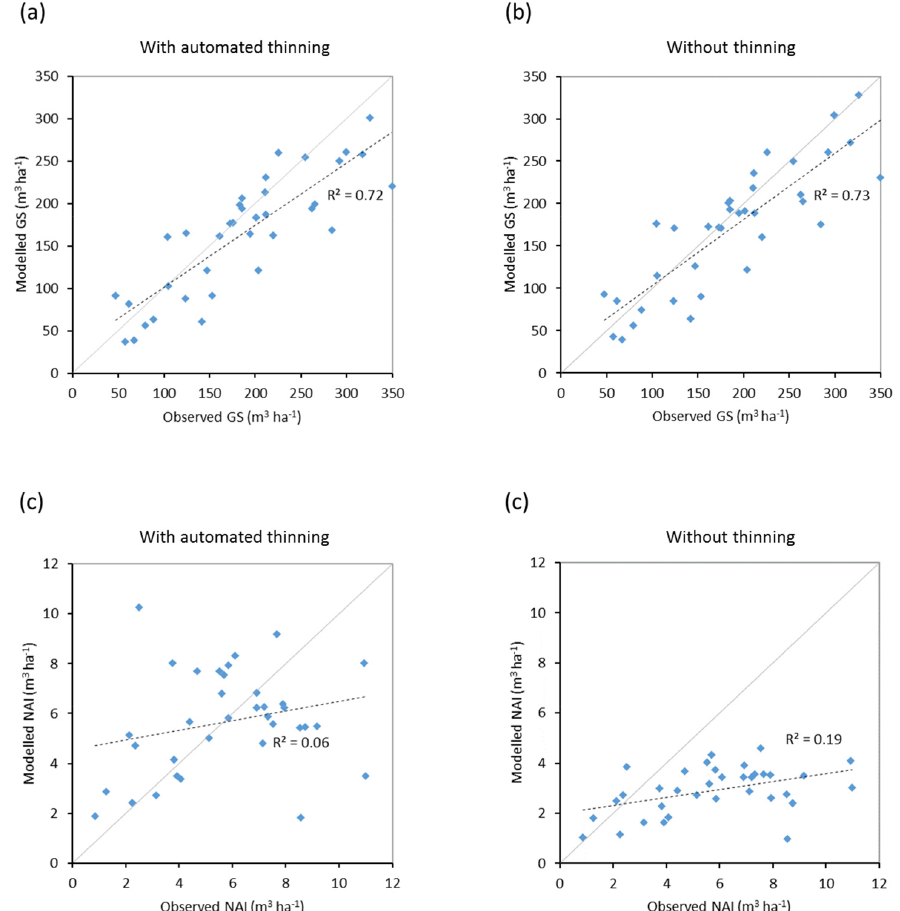
Figure 10. Modelled and observed (Forest Europe, 2015) values for individual European countries. Growing stock (GS) in 2010 (a) simula- tion with automated thinning and (b) simulation without thinning. Net annual increment (NAI) in 2001–2010 (c) simulation with automated thinning and (d) simulation without thinning. Included countries are as in Fig. 9a.